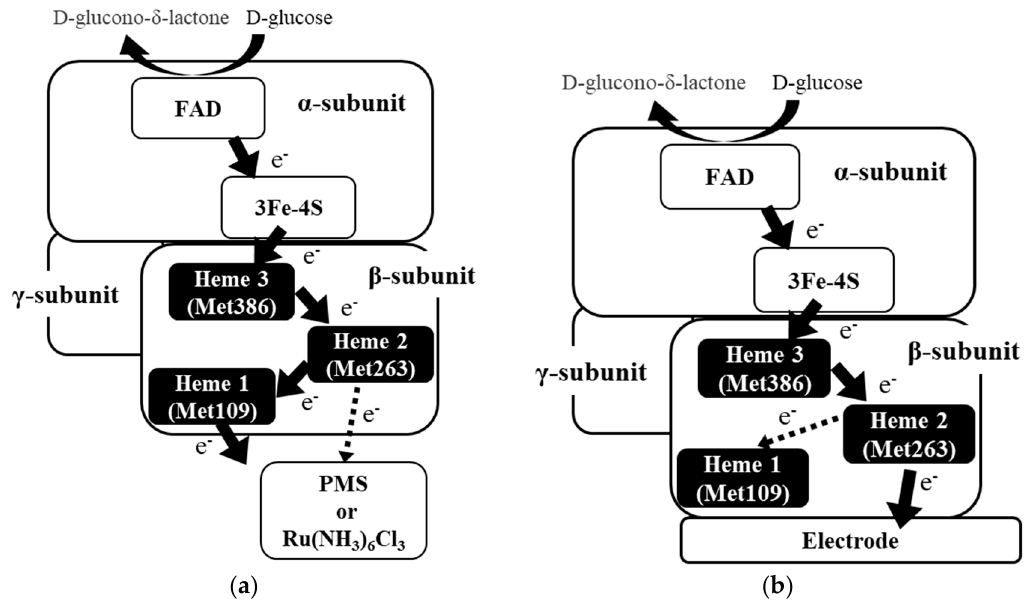
Figure 5. Schematic of the proposed electron transfer pathway of FADGDH. ( a ) Electron acceptors in a dye-mediated dehydrogenase activity assay in a solution; and ( b ) DET-type electron transfer to the electrode.